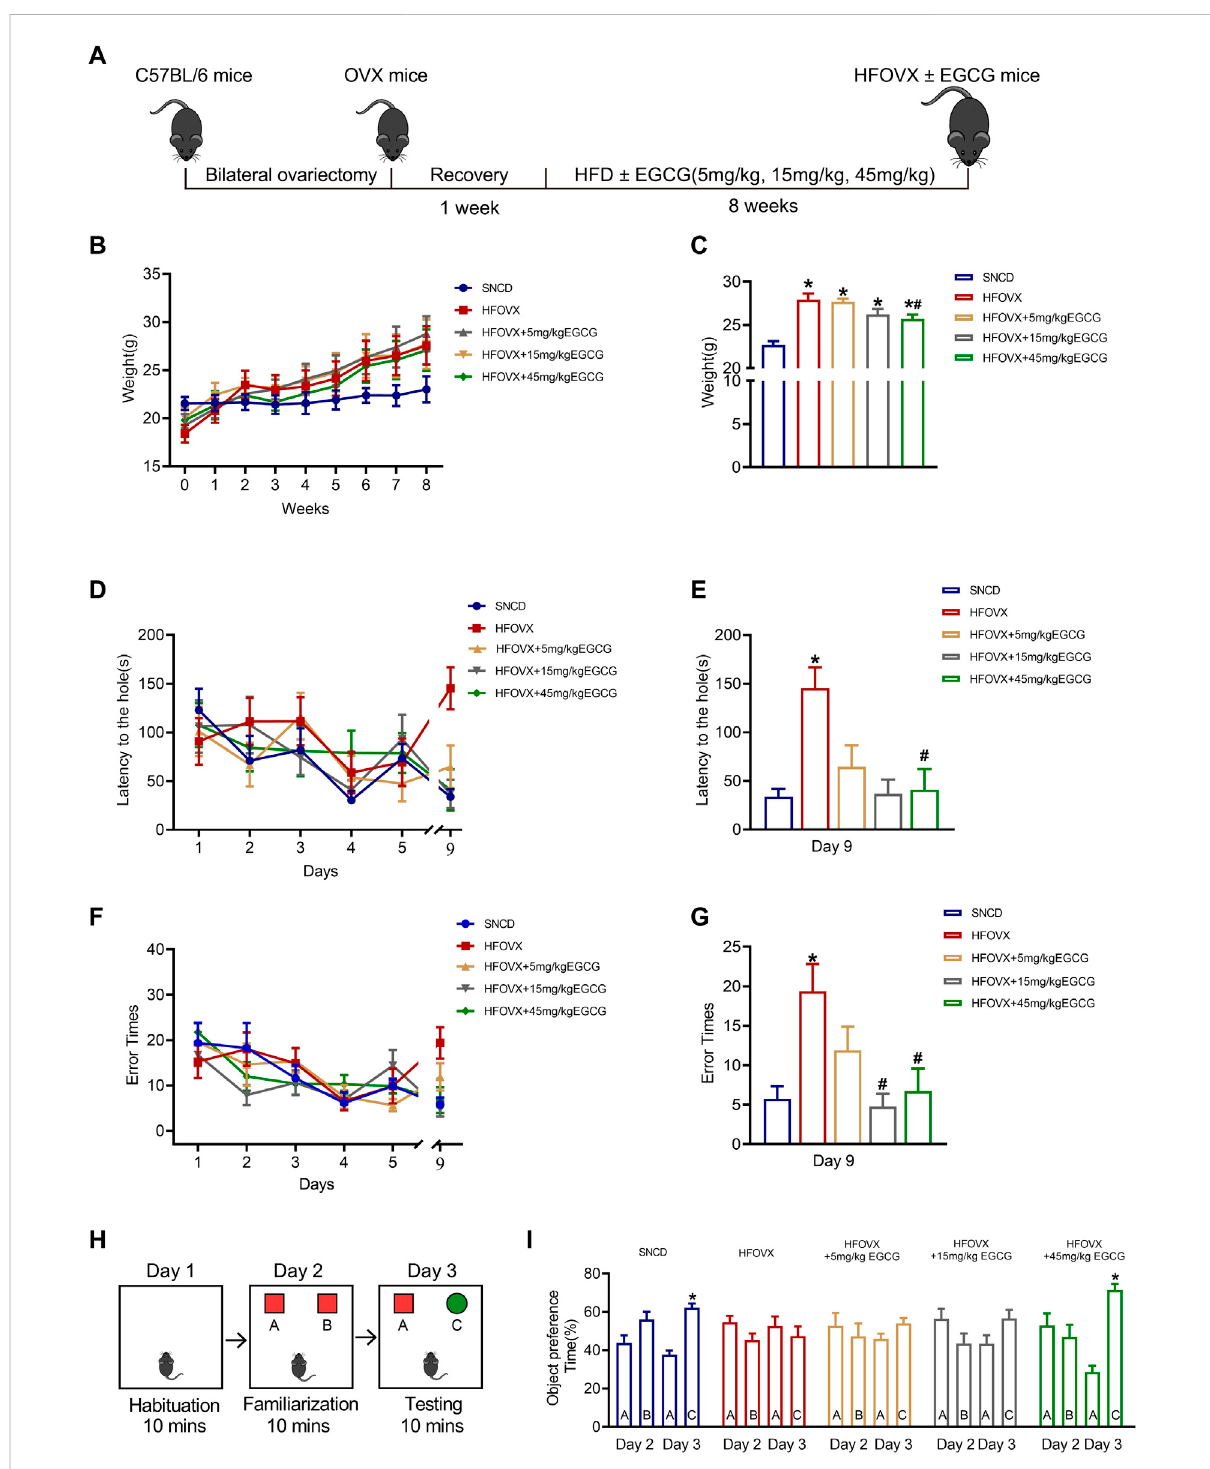
FIGURE 1 Effectsofepigallocatechin-3-galate(EGCG)onbodyweightandcognitive functioninHFOVXmice. (A) Schematicdiagramoftheexperimental design,HFD,anddifferentdosesofEGCGadministration. (B) Averageweeklyweightofeachgroup. (C) Changesinbodyweightatthe8th week.* p < 0.05 HFOVX group vs. SNCD group; # p < 0.05 HFOVX+45 mg/kg EGCG group vs. HFOVX group; n = 7 mice. (D) Latency of each group of mice duringthelearningandtestingperiods. (E) Latencyofeachgroupofmiceonthetestday. (F) Numberoferrorsineachgroupofmiceduringthe learningandtestingperiods. (G) Errortimesofeachgroupofmiceonthetestday.* p < 0.05HFOVXgroupvs.SNCDgroup; # p < 0.05HFOVX+EGCG groupvs.HFOVXgroup; n =8mice. (H) Graphicalrepresentationofnovelobjectrecognition. (I) Percentageoftimespentexploringthesameobjects on Day 2 and different objects on Day 3. * p < 0.05 preference time for C vs. A, n = 8